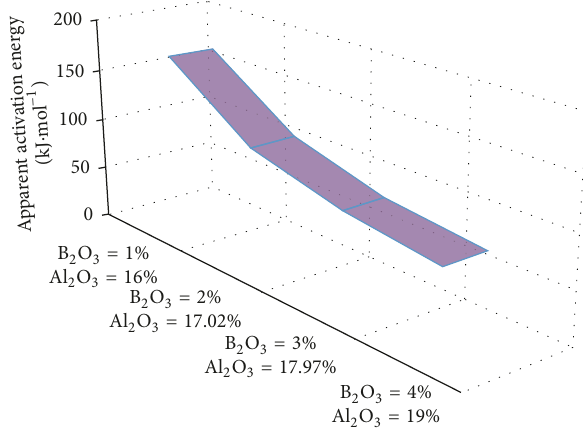
Figure 6: Break point temperature of the slag with B 2 O 3 content.